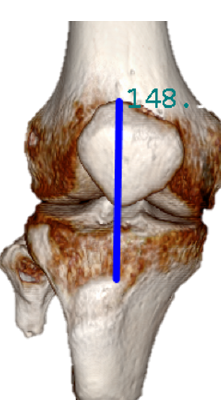
Figure 9. Three-dimensional CT image of the transtibial amputee participant.The measurement to localate the first critical regions of interest (CROI) is taken from the superior point of the patella to the middle point of the tibial